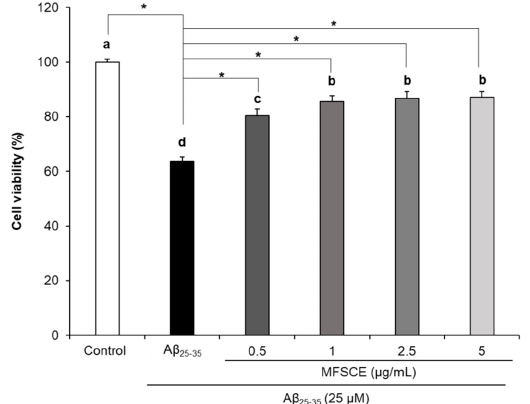
Figure 1. Effect of membrane-free stem cell extract (MFSCE) on viability of SH-SY5Y cells treated with A β 25–35 . Values are presented as mean ± SD ( n = 6). The different letters (a–d) among groups represent significant differences determined by ANOVA and Duncan’s multiple range test (p < 0.05). * p < 0.05 vs. A β 25-35 -treated cells.